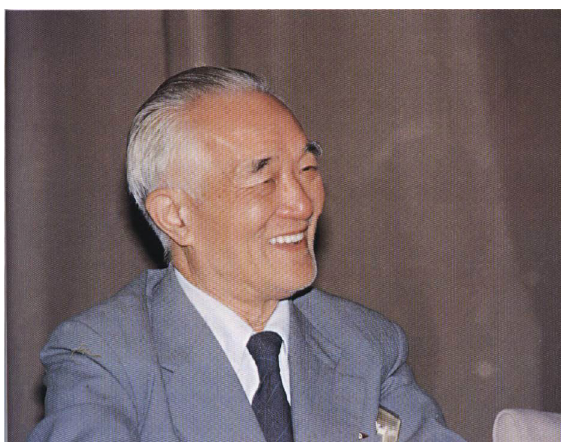
Figure 1. Dr. Fan Qingsheng: a pioneer in antibiotics